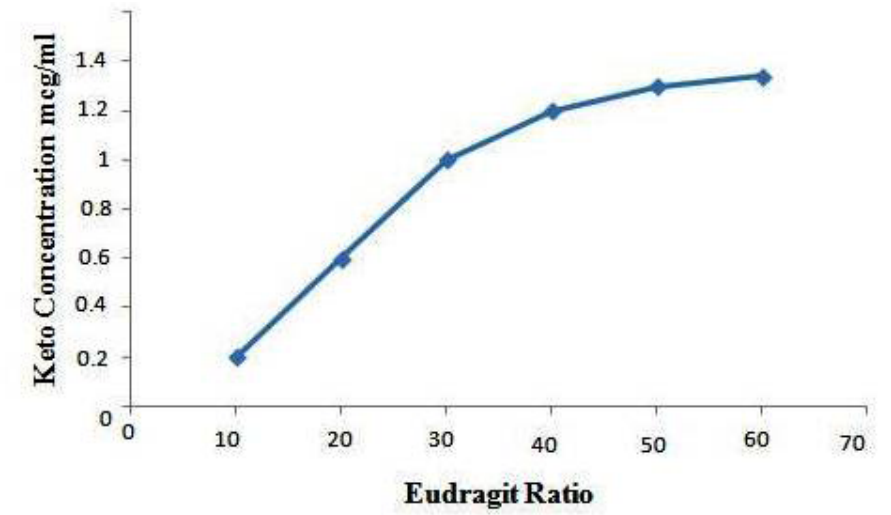
FIGURE 4 - Phase solubility of Ketoprofen:Eudragit S-100 at pH 7.4.